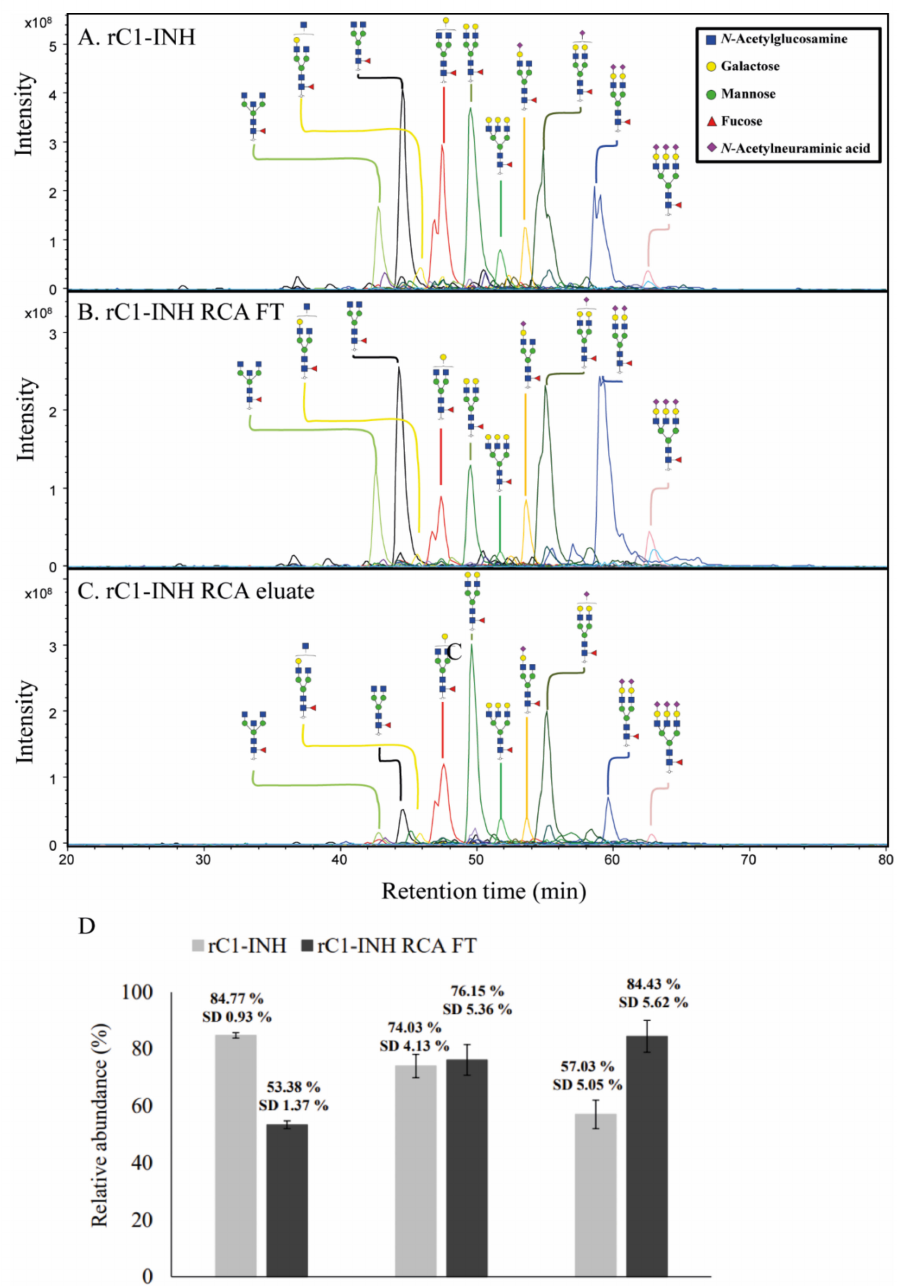
Figure 3. N -glycan of rC1-INH, rC1-INH RCA FT and rC1-INH RCA eluate. N -glycans were analyzed by PGC nano- LC-ESI-MS/MS and visualized by extracted ion chromatograms (EIC). The N -glycosylation profile of rC1-INH RCA FT ( B ) shows a reduced relative abundance of terminal galactose and an increased relative abundance of terminal sialic acid compared to the N -glycosylation profile of rC1-INH ( A ). In contrast, rC1-INH eluate displays an increased abundance of terminal galactose and reduced abundance of terminal sialic acid ( C ). The top ten most abundant glycans are annotated per sample and assigned structural schemes. These spectra are representative of three different technical replicates. ( D ) Relative abundance of key structural motifs of rC1-INH and rC1-INH RCA 120 FT. Relative quantification and structural elucidation of the 40 most abundant glycans was performed per sample (see Supplemental Figure S2). For the relative abundances of the glycan motifs, terminal galactose, terminal GlcNAc and terminal sialic acid, the relative abundance of glycans carrying these motifs were multiplied by the number of these motifs per glycan and summed. Analyses were performed in triplicate and the standard deviation (SD) is